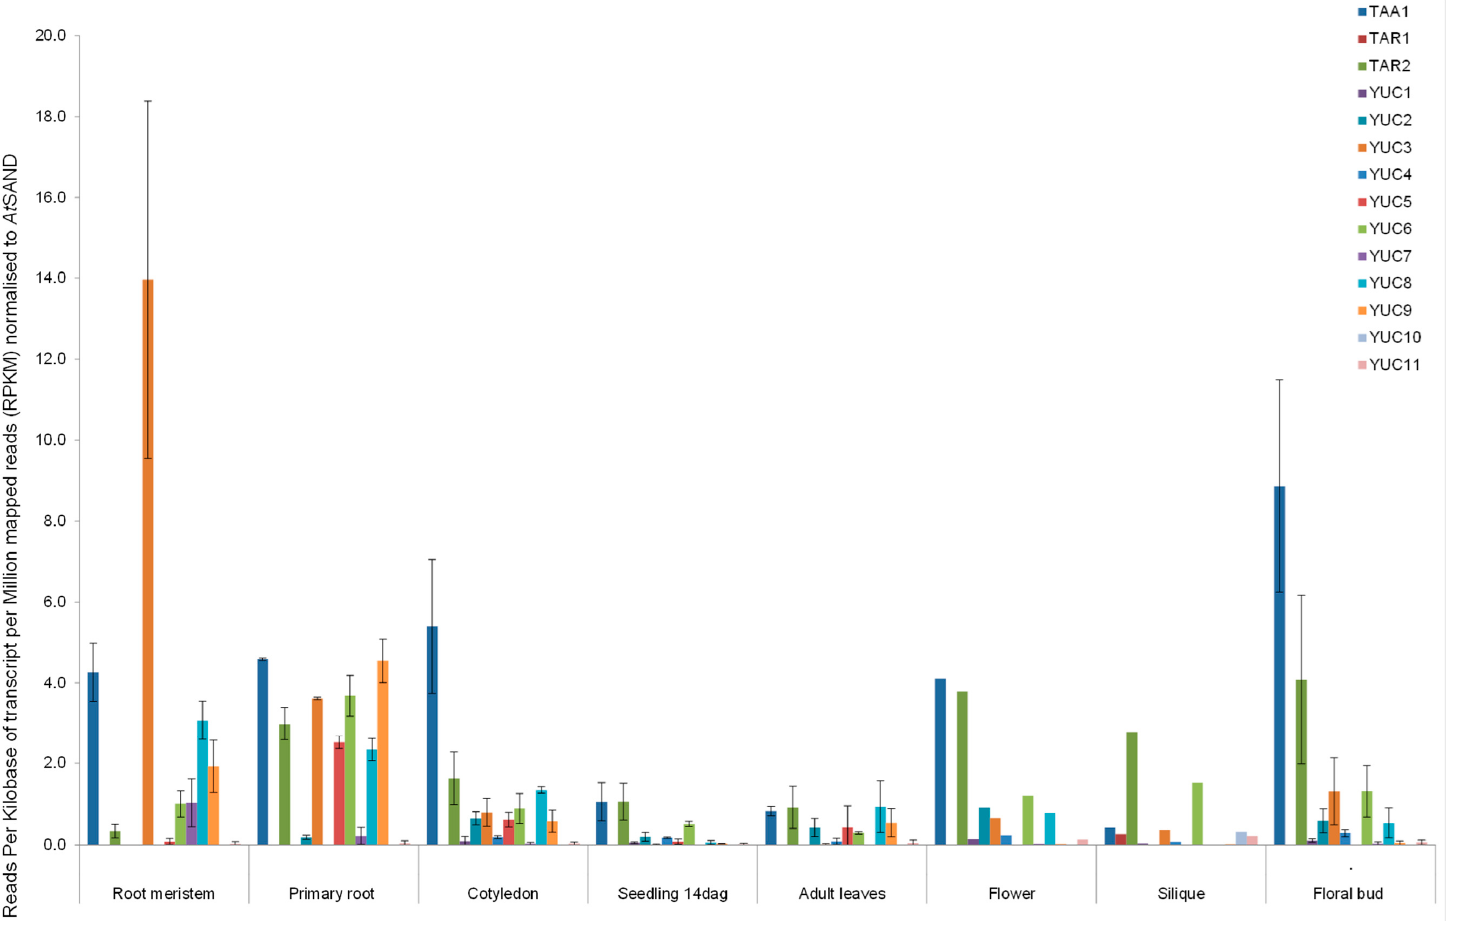
Figure 6. Tissue-specific distribution of TAA/TAR and YUC transcripts.